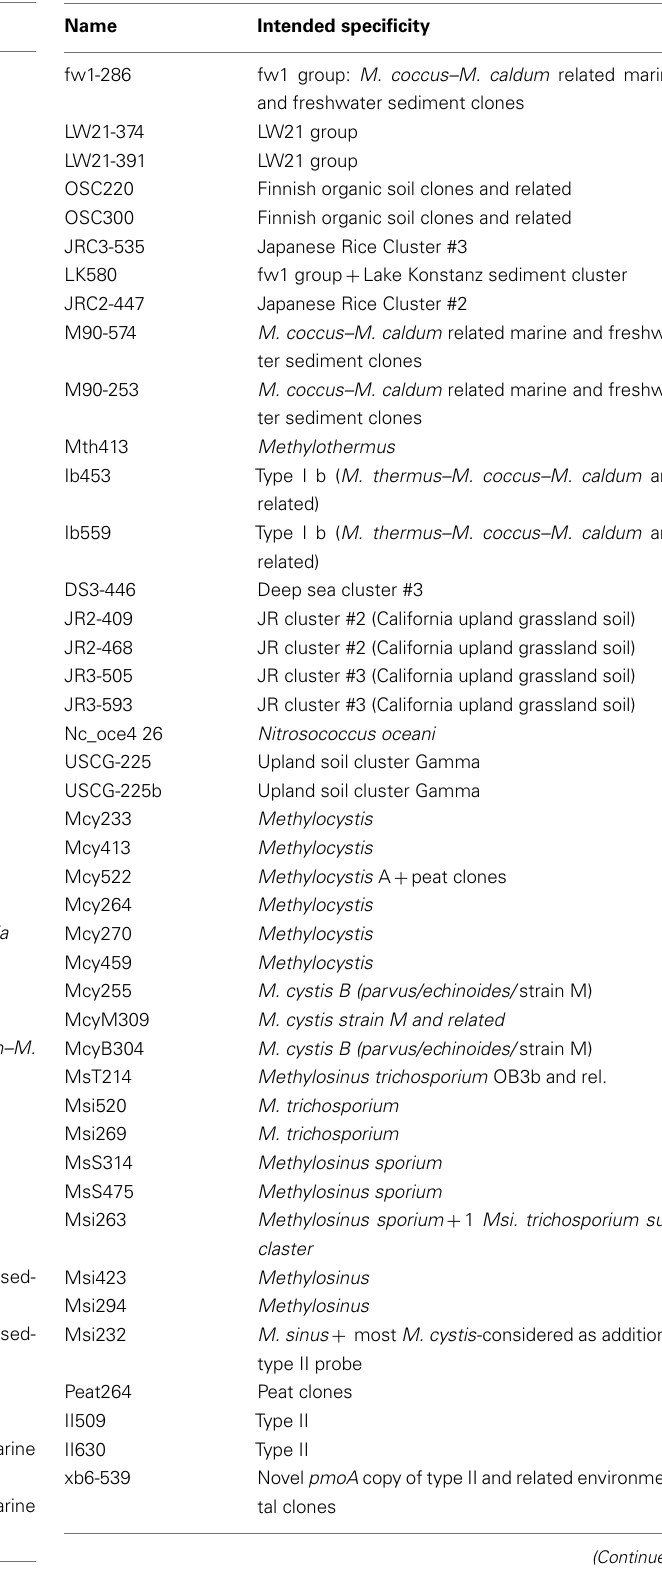
TableA2 |The microarray probe set used in the study and probe